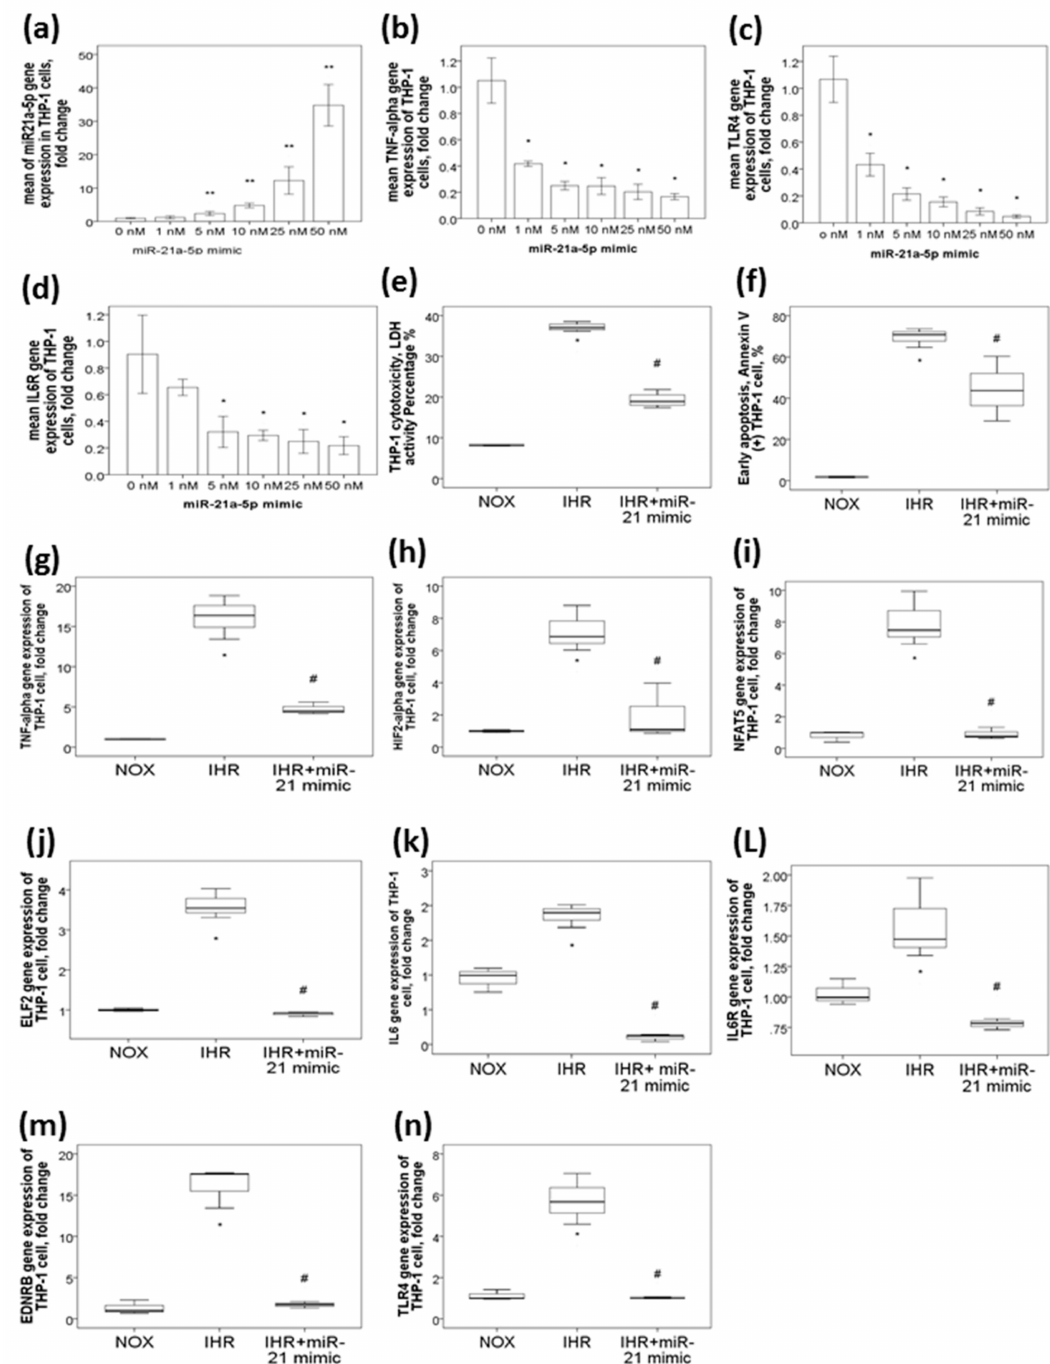
Figure 3. miR-21-5p mimic transfection suppressed IHR-induced cytotoxicity / apoptosis, and inhibit IHR-induced upregulations of several predicted target genes, including TNF- α , HIF-2 α , NFAT5 , ELF2 , IL6 , IL6R , EDNRB , and TLR4 . miR-21-5p transfection ( a ) enhanced miR-21-5p expression and suppressed ( b ) TNF- α , ( c ) TLR4 , and ( d ) IL6R gene expressions under normoxic (NOX) condition in a dose-dependent manner. Intermittent hypoxia with re-oxygenation (IHR) augment ( e ) cytotoxicity, ( f ) early apoptosis, and increased gene expressions of the ( g ) TNF- α , ( h ) HIF2- α , ( i ) NFAT5 , ( j ) ELF2 , ( k ) IL6 , ( l ) IL6R , ( m ) EDNRB , and ( n ) TLR4 genes, while all of these changes were reversed with miR-21-5p transfection under IHR condition. * p < 0.05, compared with 0 nM miR-21-5p mimic or NOX condition. ** p < 0.01, compared between IHR and NOX condition by Mann-Whitney test. # p < 0.05, compared with IHR alone